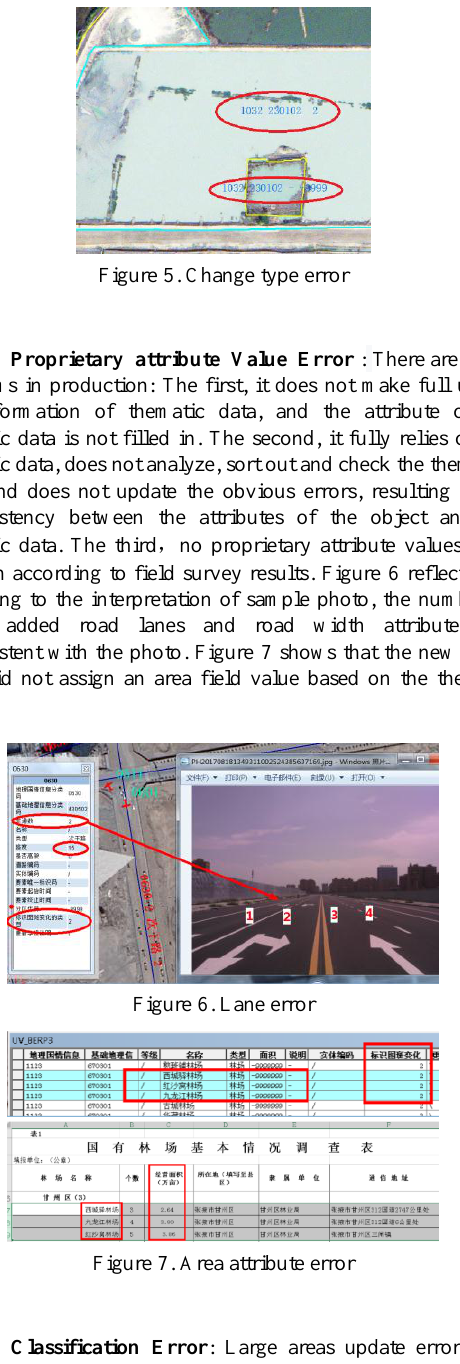
Figure 3. Road constraint error Figure 4. River constraint error